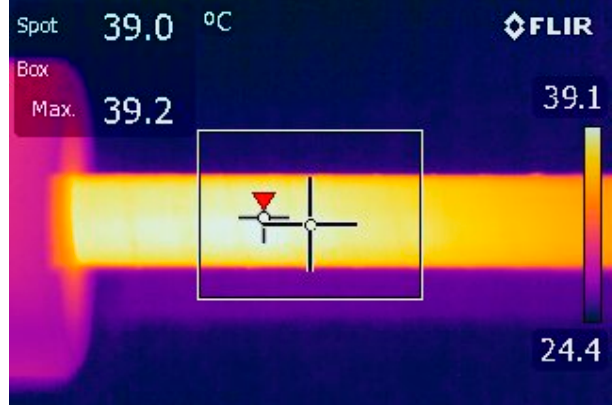
Figure 5. A sample temperature distribution in the heater.